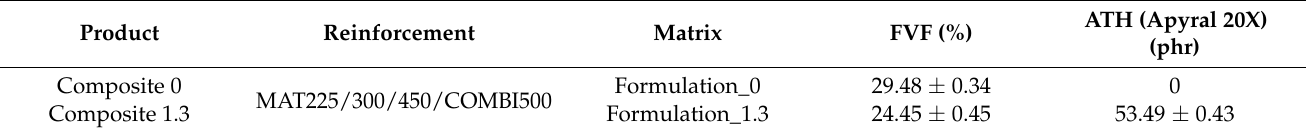
Table 4. Composition of the manufactured composites.